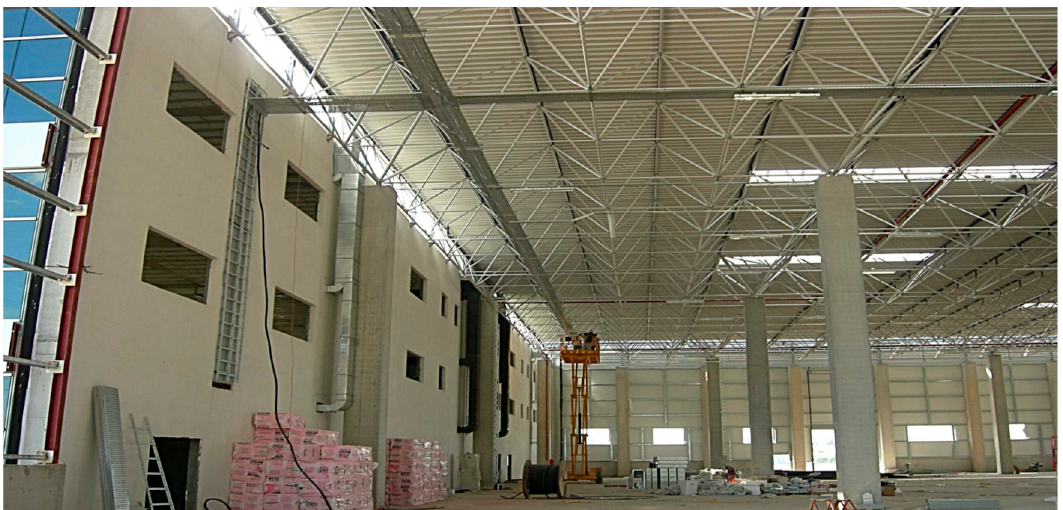
Figure 3. Overview of the roof structure.